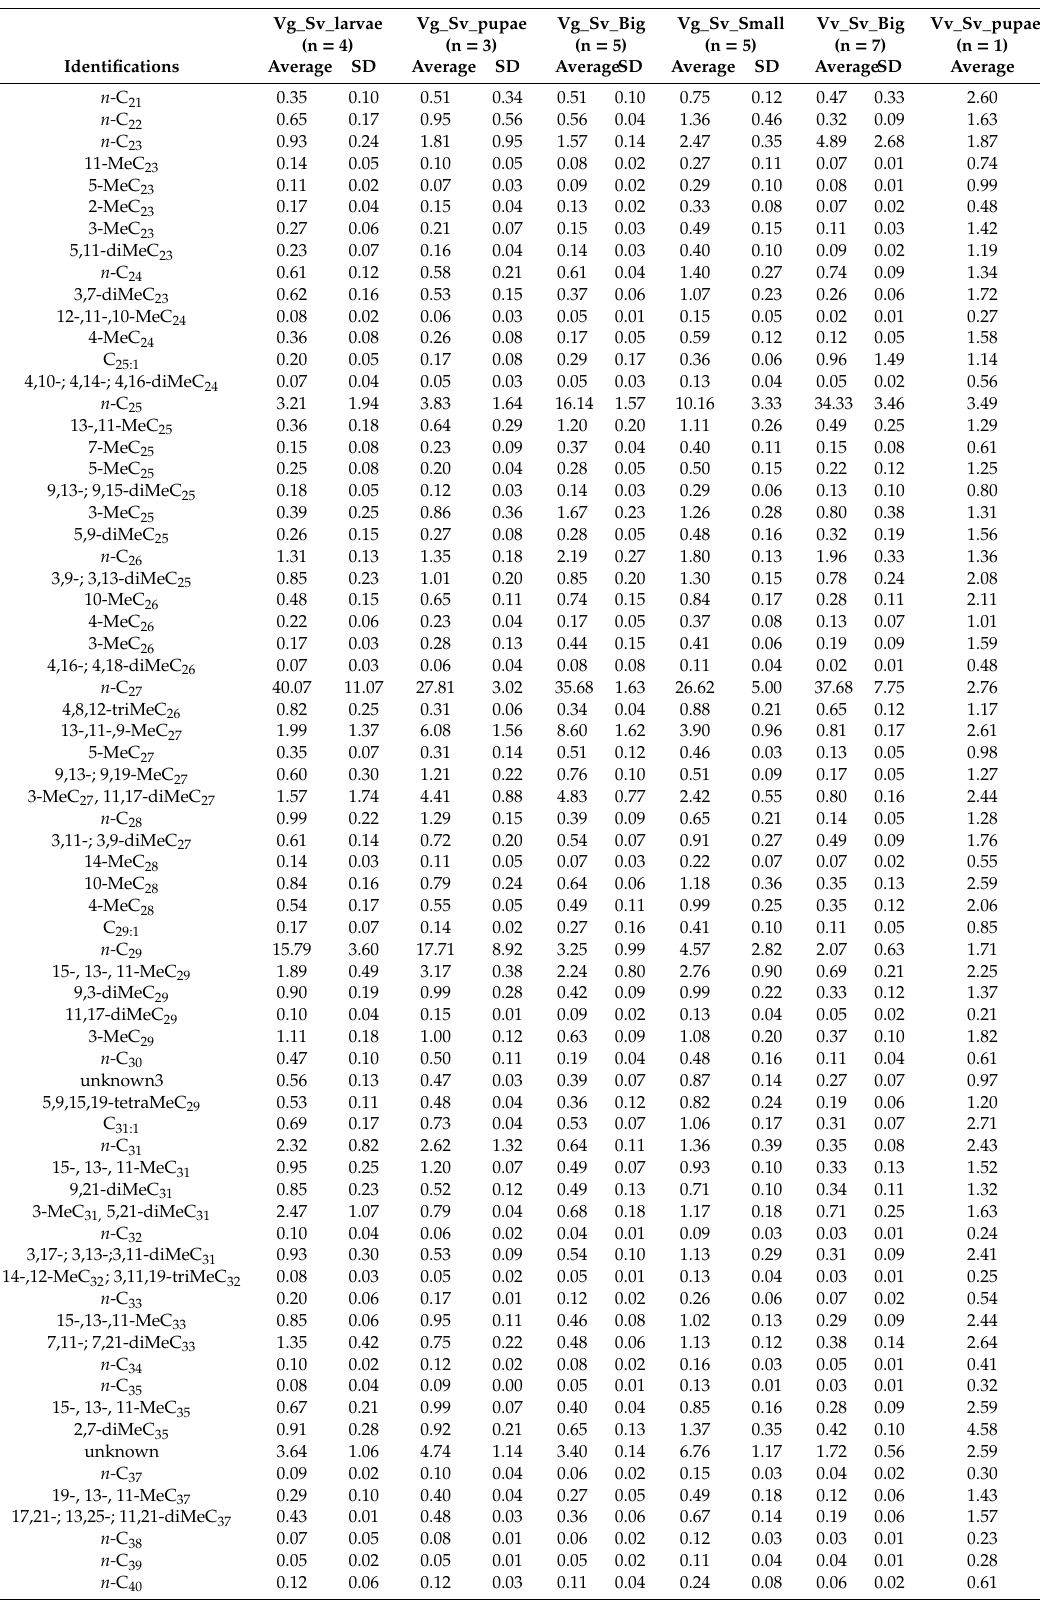
Table 1. List of hydrocarbons found in di ff erent life stages of the ectoparasitoid Sphecophaga vesparum and their relative amounts. Vg and Vv indicated if they were collected at the Vespula germanica or Vespula vulgaris nest. “Big” indicated the winged form of S. vesparum and “Small” indicated the brachypterous form. n = number of individuals. SD = standard